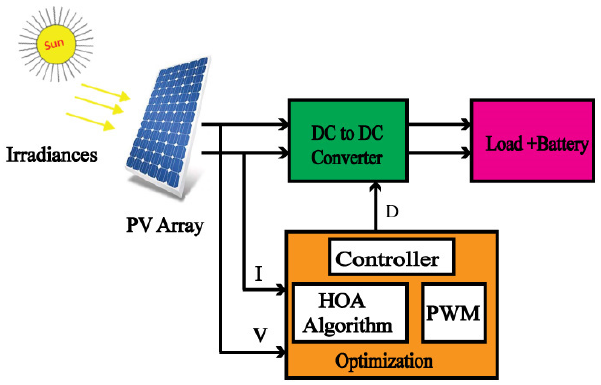
Figure 1. An optimized PV system diagram.